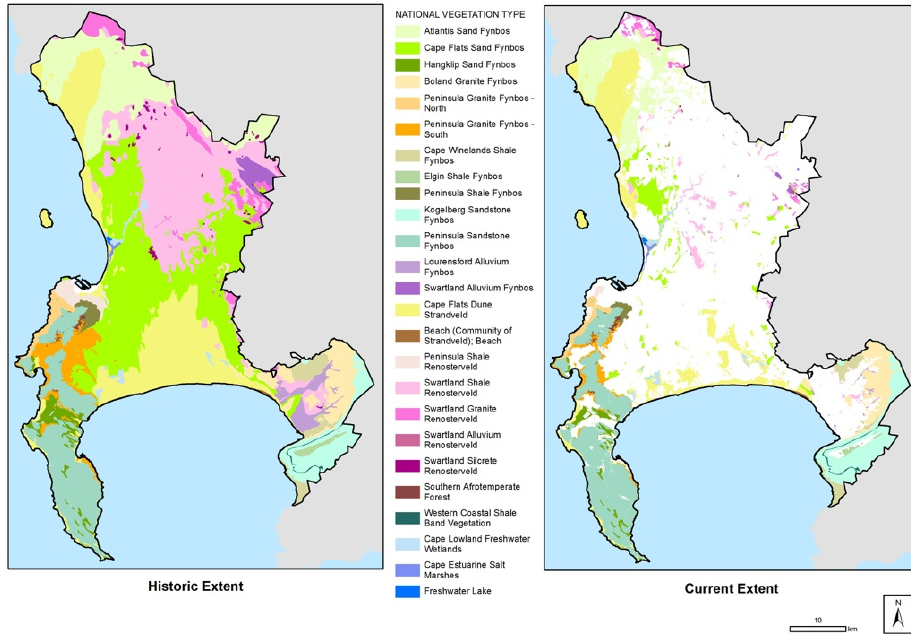
Figure 2. Di ff erent vegetation types within the fynbos biome showing the historical distribution and remaining patches on the left in 2017 [19]. (Reproduced with permission from [9]) .